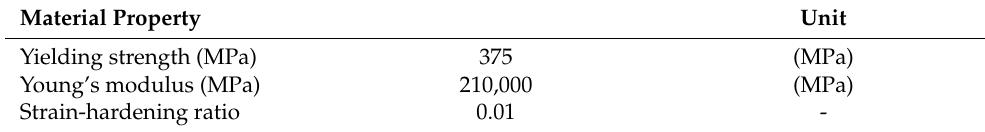
Table 2. Characterization of steel materials.